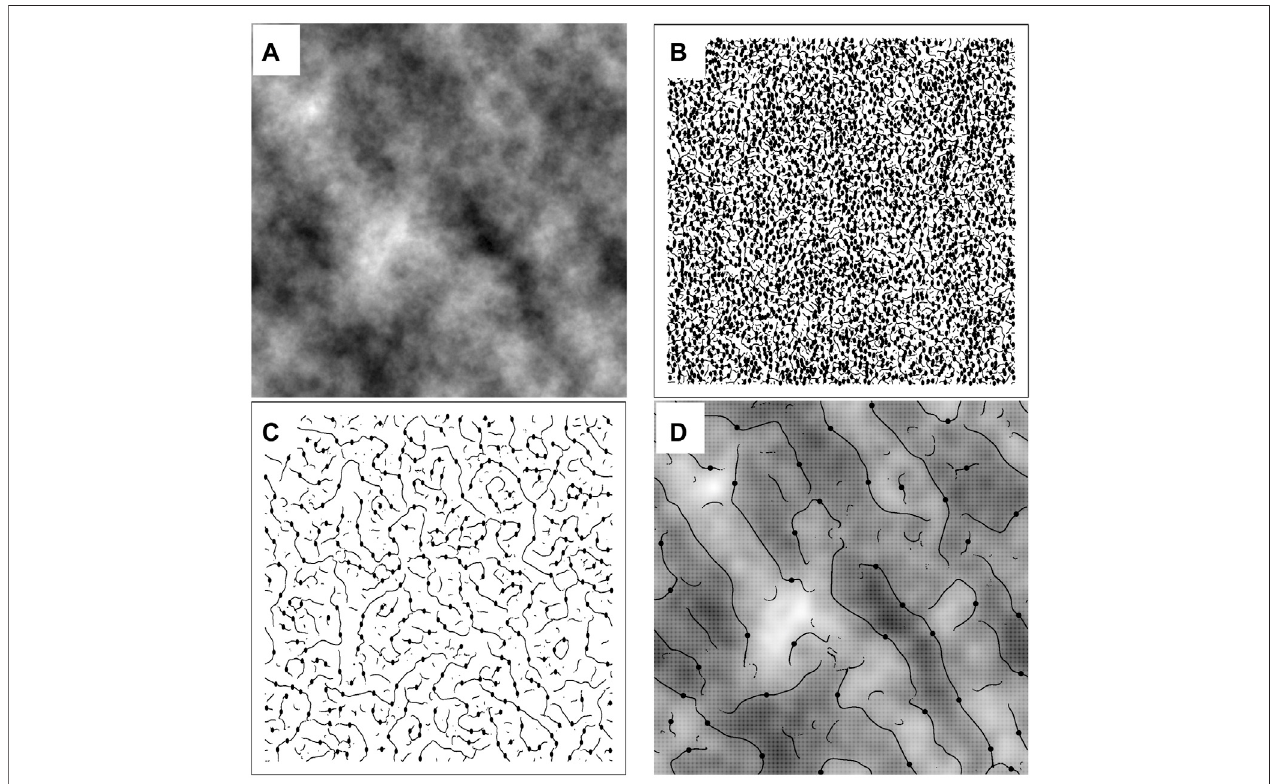
FIGURE2|(A) A512×512-pixel fBmsurfacewith H =0.7. Themaximachains,i.e.,positionswhere themodulus M ψ [ f ]( b , a ) from Eq.1 ismaximum,areshown asblacklineswhiletheWTMMMarerepresented asblackdotsforscale a =20 pixels (B) , a =56 pixels (C) ,and a =158 pixels (D) .Alsoshownin (D) istheoverlayofthe maxima chains and WTMMM on the original image smoothed with the Gaussian function G at scale a = 158 pixels. The WTMMM are then connected across scales to make the WT Skeleton shown in Figure 3 .